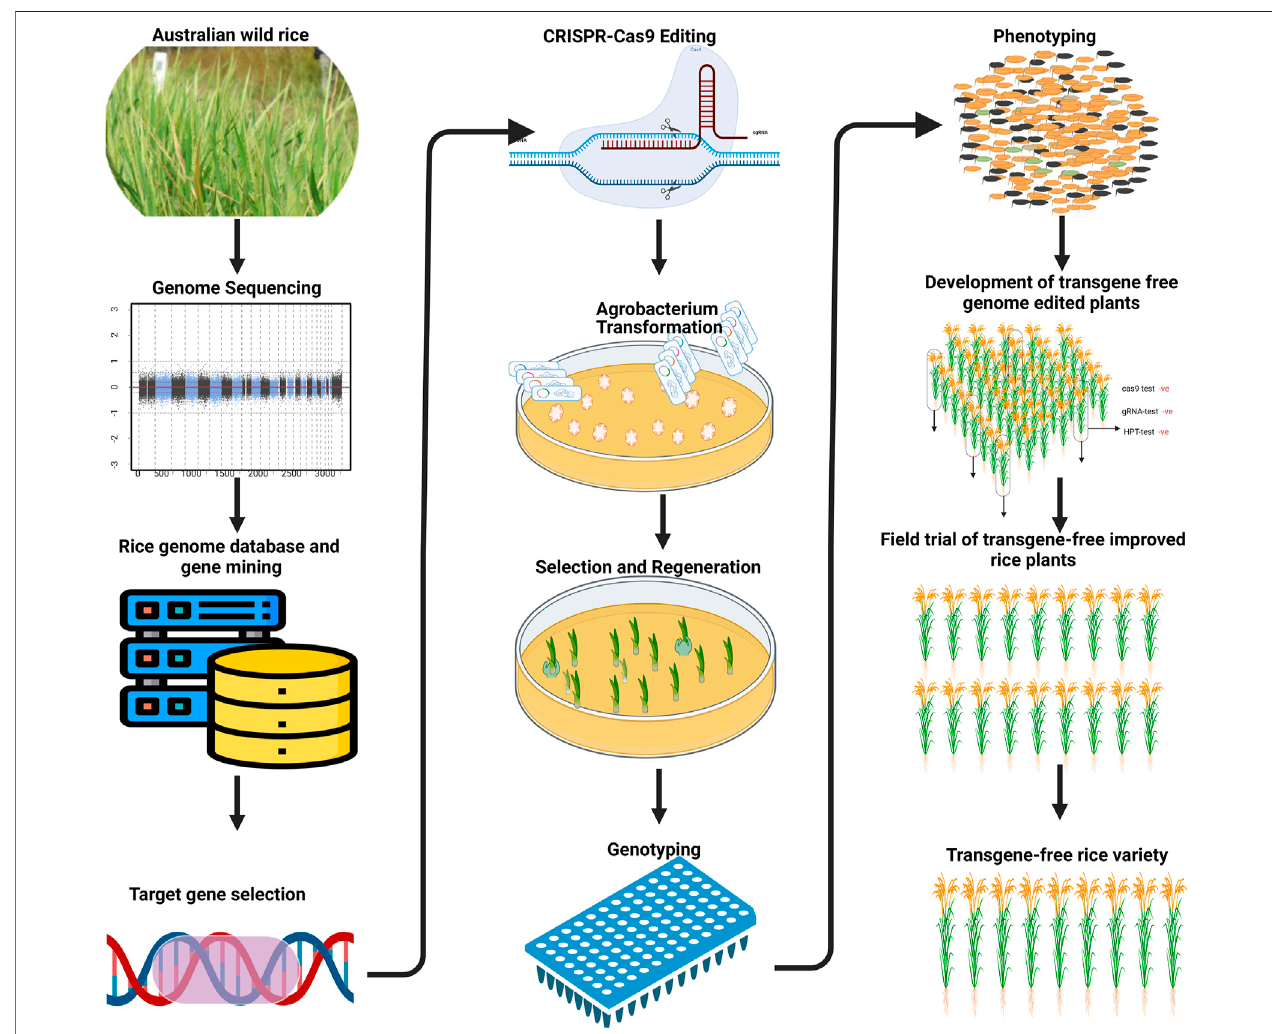
FIGURE 1 | Schematic diagram shows the denovo domestication of Australian wild rice through genome editing.